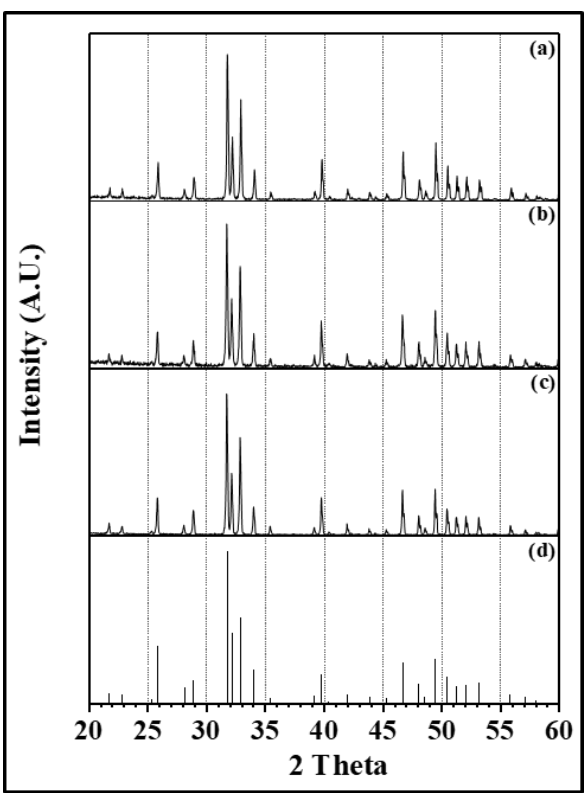
Figure 7. XRD patterns obtained from ( a ) the part of the flash sintered sample with no whitening, ( b ) the whitened part of the flash sintered sample under 1200 V, ( c ) the pale blue color sample after normal sintering at 1200 ◦ C for 5 minutes, and ( d ) the PDF file (No. 9-432) of